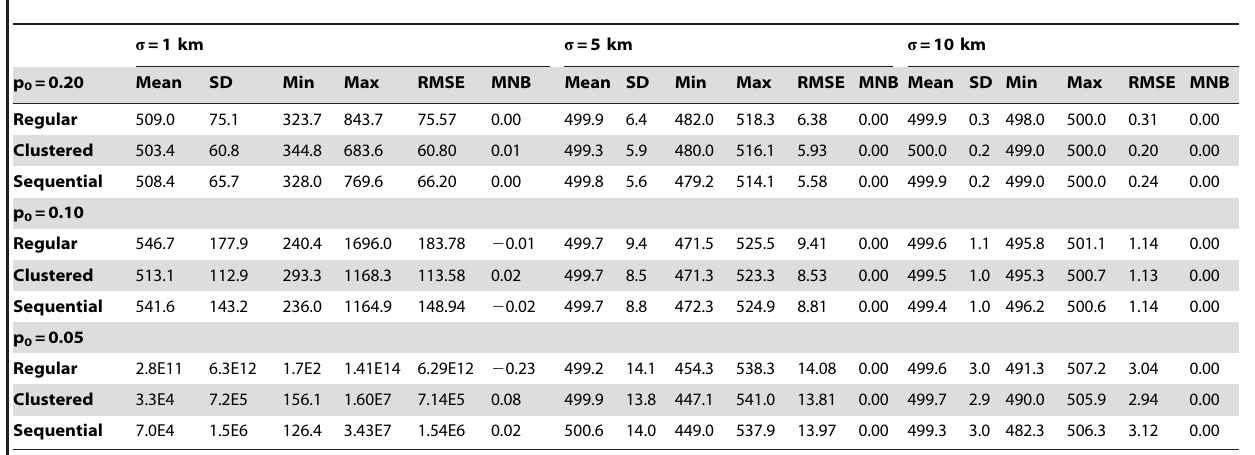
Table 3. Summary estimates of ^ NN when true population size N=500 and J =128 traps, under each of the three trap arrangements: regular, clustered, and sequential, where mean, standard deviation (SD), range, root mean squared error (RMSE), and mean normalized bias (MNB) are given for each scenario ( p x s x configuration) .